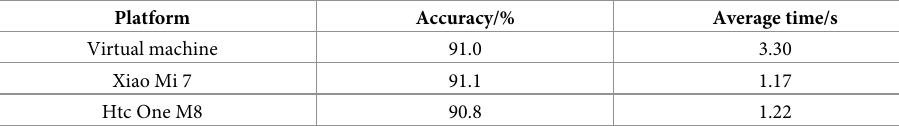
Table 6. Experimental results on different